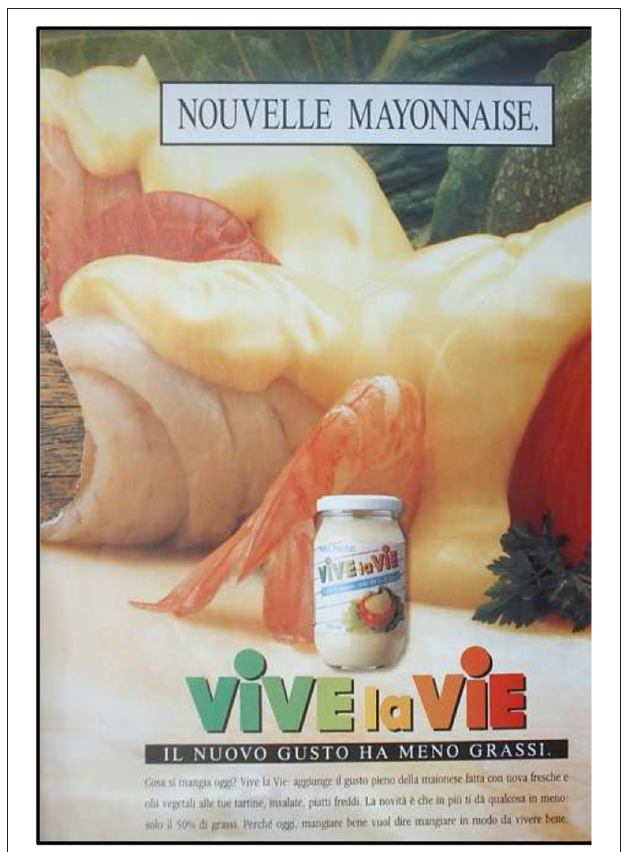
FIGURE 8 | Vive la Vie. The new taste has less fat.